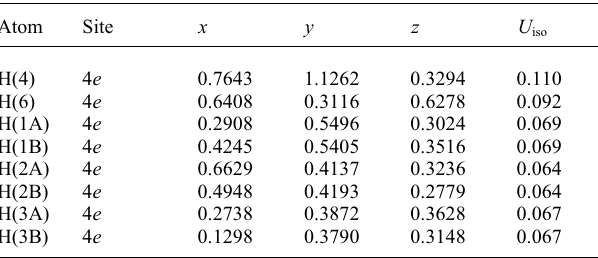
Table 2. Atomic coordinates and displacement parameters (in Å 2 )